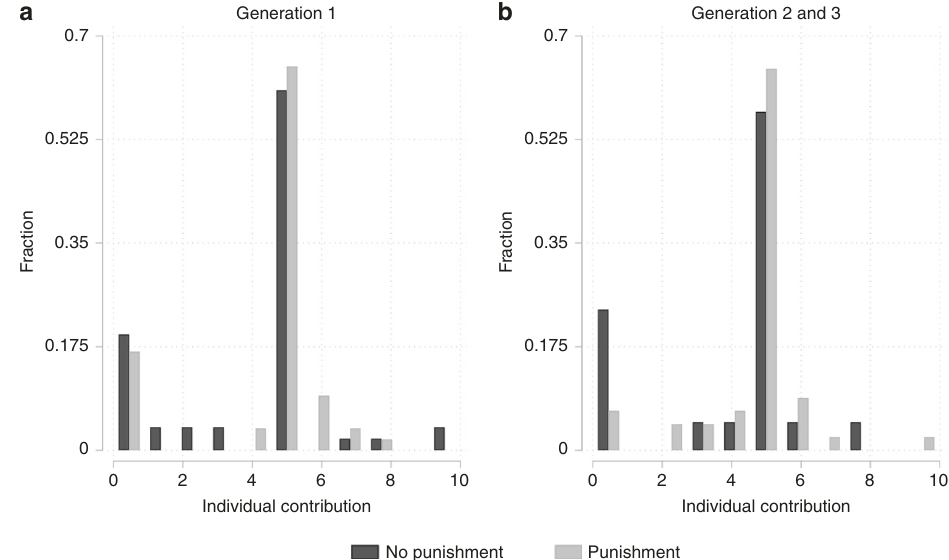
Fig. 3 Individual contributions in the no-punishment and punishment conditions. a Contribution decisions of the initial group (a total 51 and 54 decisions in the no-punishment and punishment conditions, respectively). b Contribution decisions of subsequent groups (a total 21 and 45 decisions in the no- punishment and punishment conditions,